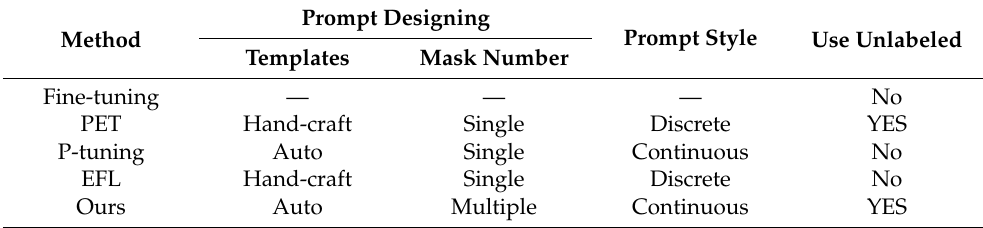
Table 2. The difference between the baseline methods.